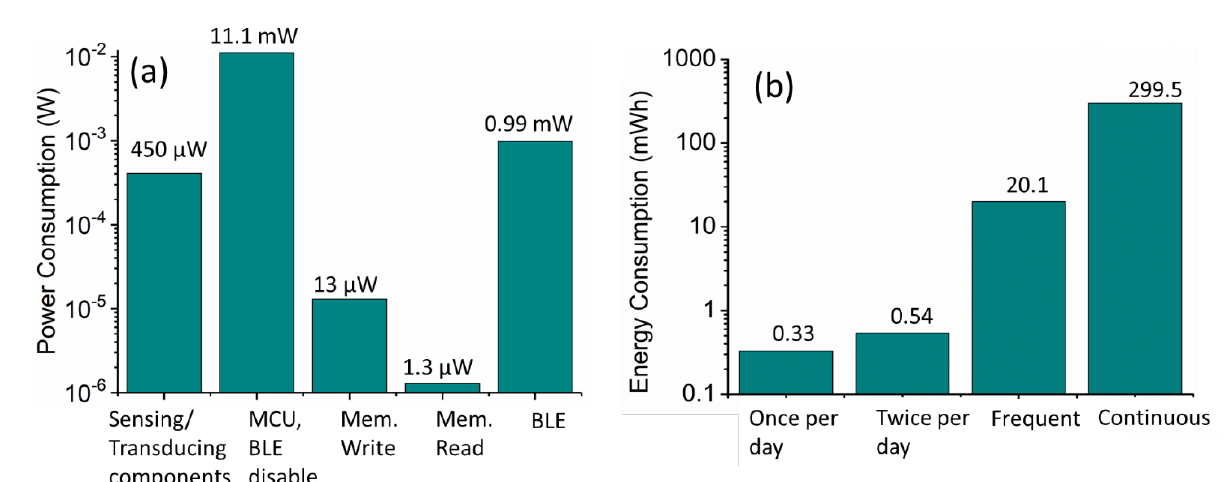
Figure 1. ( a ) the energy consumption of the key components in a wireless sensor system monitoring PPG, ECG, and temperature simultaneously, ( b ) Energy consumption in a day for “continuous measurement,” “frequent measurement,” and “measurement once or twice a day.” Figure adapted from Yu et al. [32].